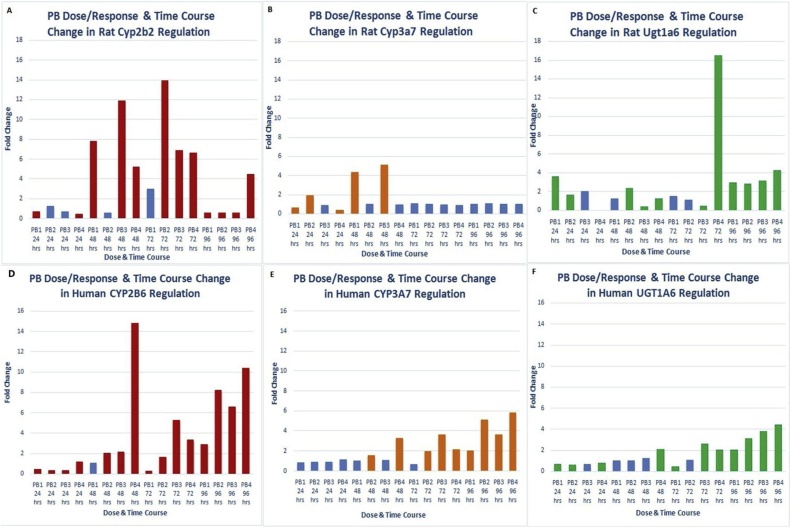
Effects of PB treatment over time on the induction (fold change) of CAR-regulated genes.(A) rat Cyp2B2; (B) rat Cyp3A7; (C) rat Ugt1A6; (D) human CYP2B6; (E) human CYP3A7; (F) human CYP1A6. NB: Red/orange/Green data bars show fold change values significantly (Adjusted p < 0.05) different from control. Blue data bars show non-significant (Adjusted P > 0.05) fold change data values. PB1 = phenobarbital 500 u M; PB2 = phenobarbital 750 u M; PB3 = phenobarbital 1000 u M; PB4 = phenobarbital 2000 u M.